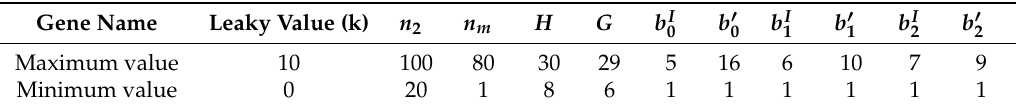
Table 3. The range of the basic